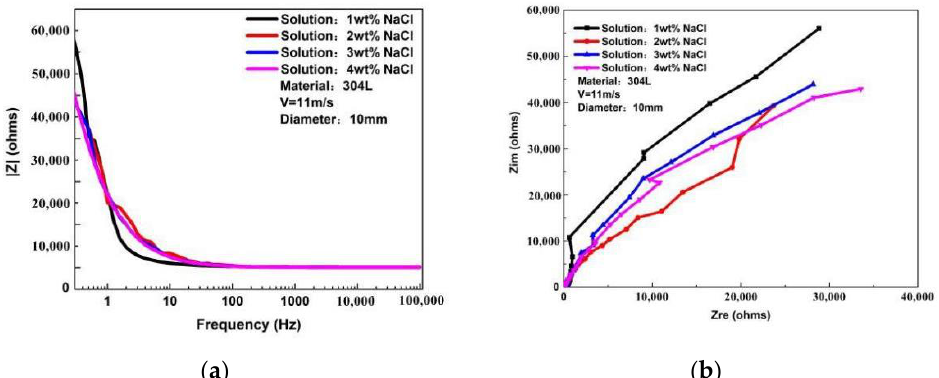
Figure 12. Electrochemical impedance spectra of 304L stainless steel in liquids with different NaCl concentrations. ( a ) Nyquist diagram of electrochemical impedance spectra of 304L stainless steel in liquids with different NaCl; ( b ) Bode diagram of electrochemical impedance spectra of 304L stain- less steel in liquids with different NaCl.